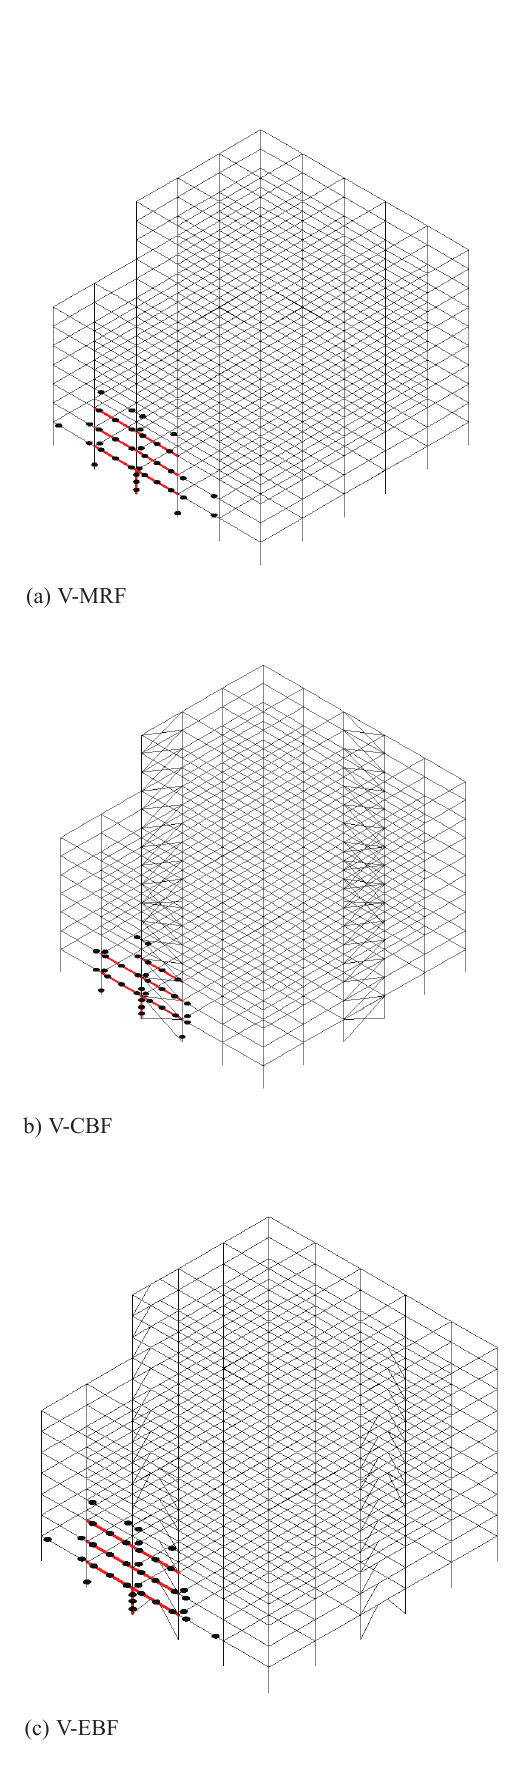
Fig. 7. Member failure and plastic hinge locations for vertically irregular MRF, CBF, EBF – Blast Location